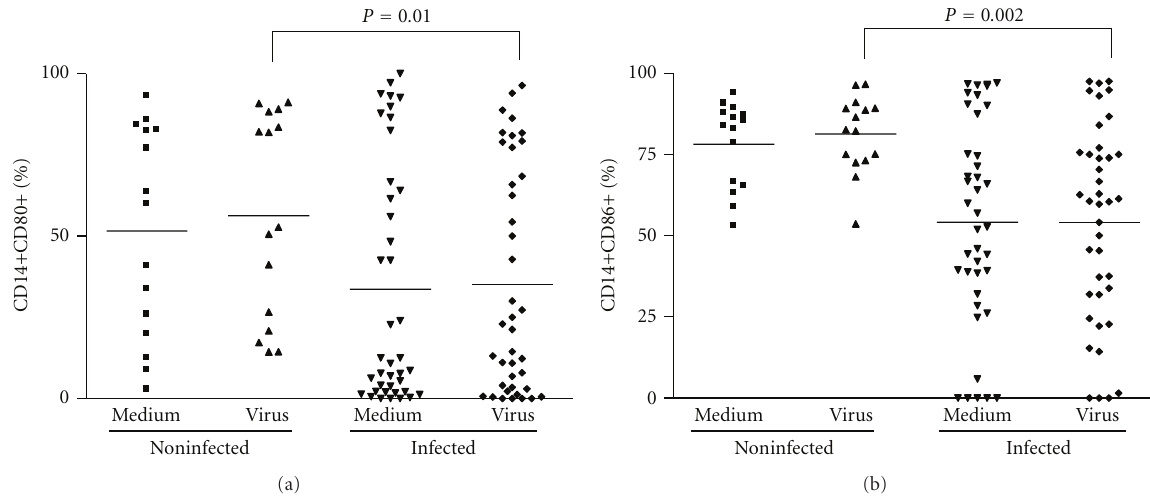
Figure 6: Monocyte (CD14 + ) activation status in PBMCs from individuals infected or not by zoonotic Vaccinia virus. Peripheral blood mononuclear cells (PBMCs) from patients infected or not with zoonotic Vaccinia virus were cultured in the presence of UV-inactivated virus or mock-treated (medium). After 72 hours of stimulus, cells were fixed, counted, and the following parameters were evaluated by flow cytometry using specific mouse anti-human antibodies: (a) percentage of monocytes (CD14 + ) expressing CD80 surface activation marker; (b) percentage of monocytes (CD14 + ) expressing CD86 surface activation marker. Statistical significance ( P values), based on the median values of each group, is presented on the